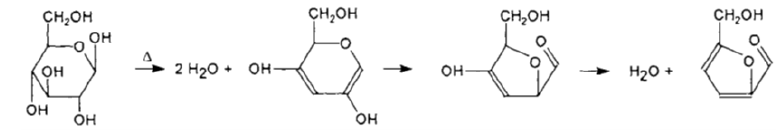
Figure 7. The formation of 5-Hydroxymethyl-2-furancarboxaldehyde.